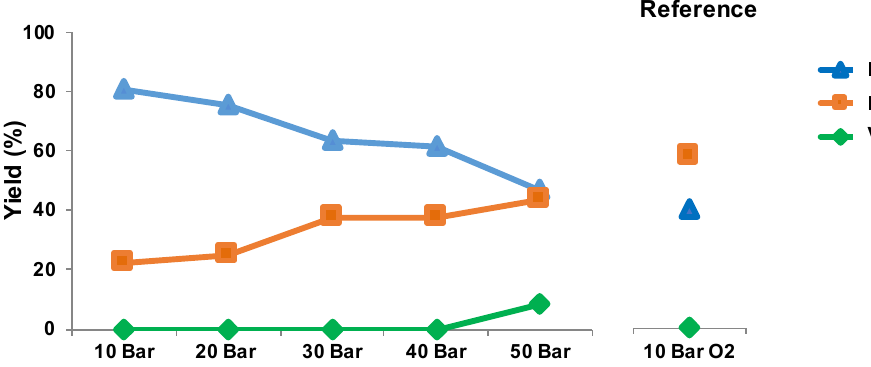
Figure 3. Yields obtained during oxidative depolymerization of LN2 with different air pressure compared to 10 bar oxygen pressure.